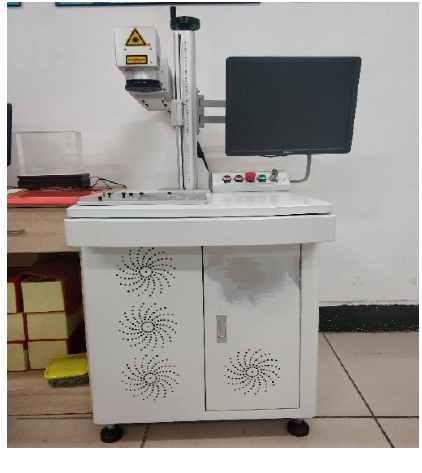
Figure 7. Fiber laser.